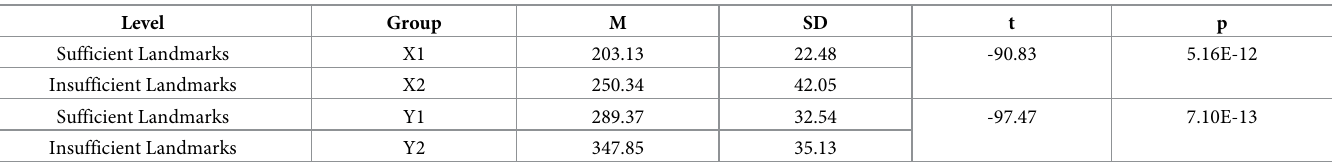
Table 3. Task completion time.